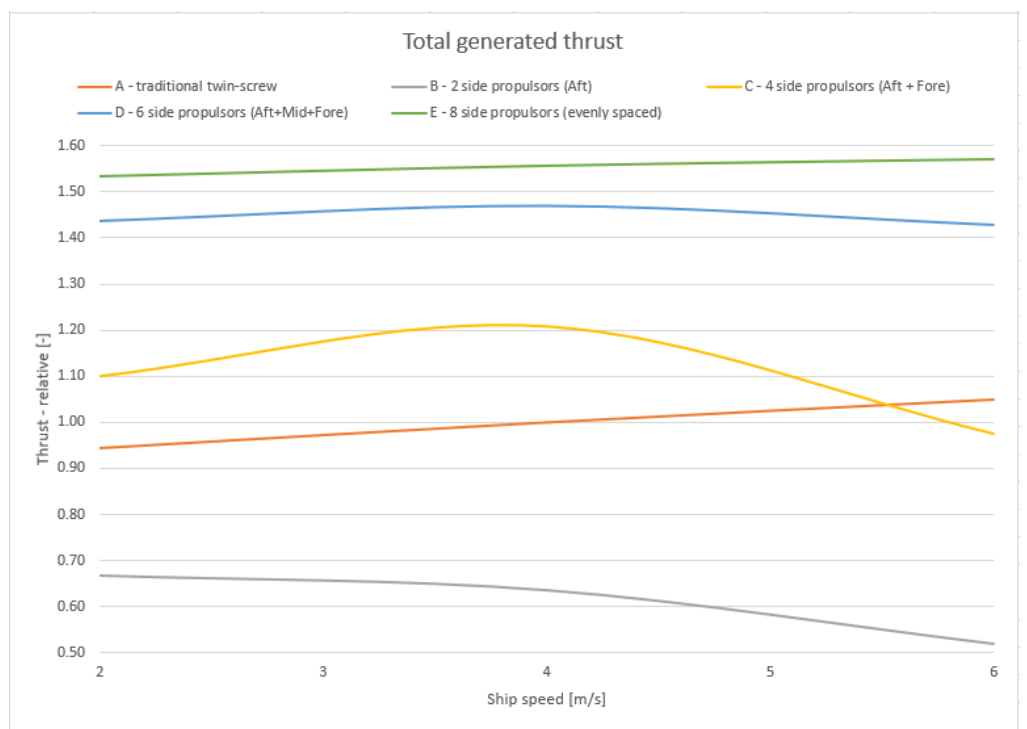
Figure 7. Total mass flow rate, shallow water (comparison). Source: Authors. J. Mar. Sci. Eng. 2020 , 8 , x FOR PEER REVIEW